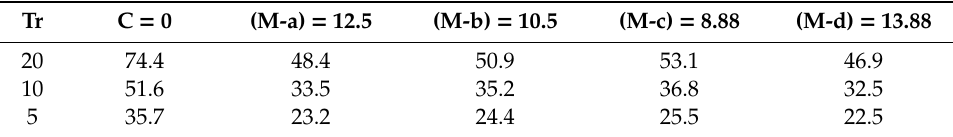
Table 5. Precipitation intensities (mm / h) for di ff erent return periods, estimated at station CH-03 for duration of 10 min and di ff erent proposed values of parameter C.